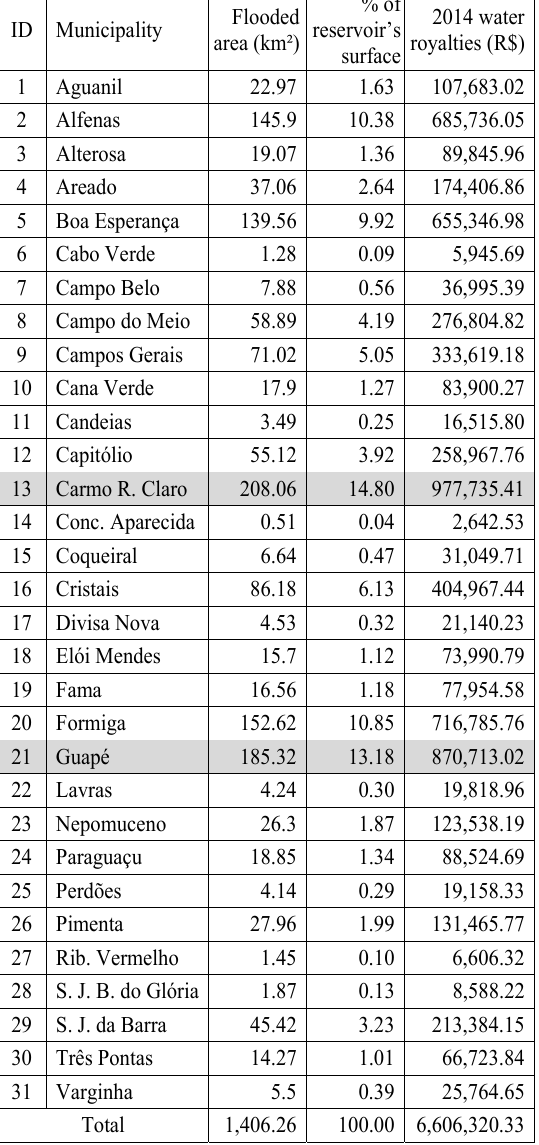
Table 1. Municipalities bordering Furnas reservoir, their flooded areas, percentage contribution to the area of the reservoir and water royalties received from ANEEL during 2014.